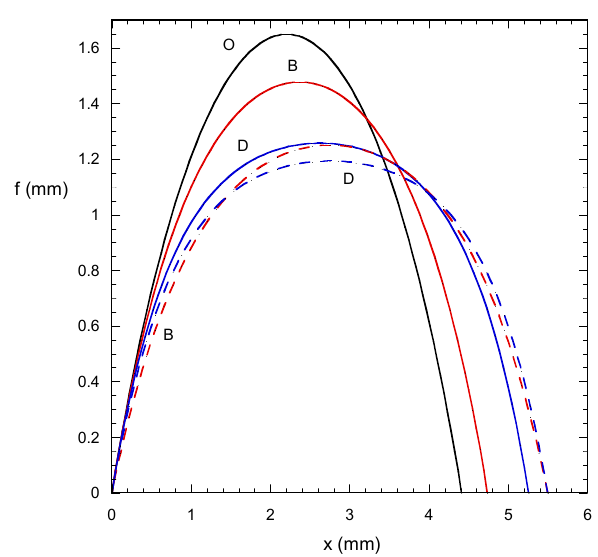
Figure 11. Comparison between droplet profiles at positions B (red lines) and D (blue lines) following the continuous (solid lines) or the left stepwise (dashed lines) C– δ trajectories shown in blue in Figure 9 (V A = 5 mm 2 , θ a = 60°, θ o = 60°, Bo N = C N /2.5).